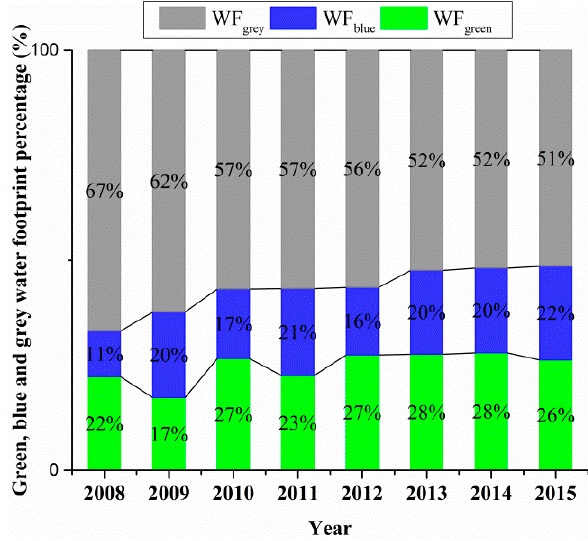
Figure 8. The percentage of green, blue, and grey WFs from 2008 to 2015 in Jilin Province.